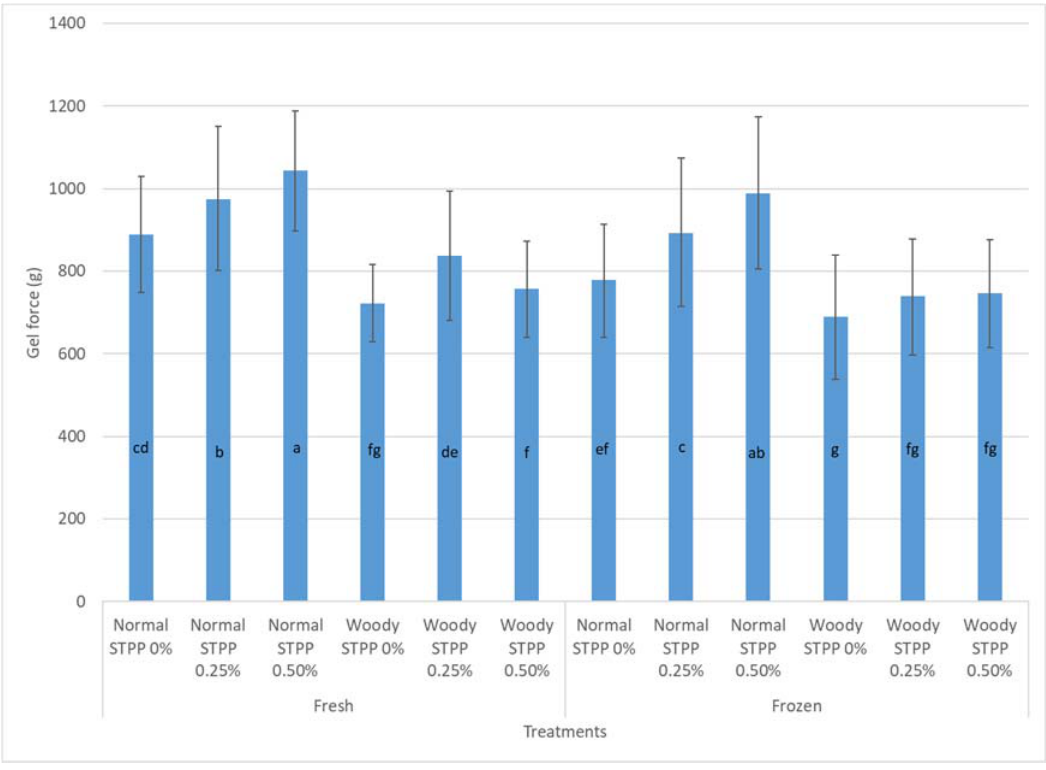
Figure 1. Gel strength (g) of fresh vs. frozen ground chicken breast meat prepared with woody and normal breast fillets with sodium tripolyphosphate (STPP; 0, 0.25, 0.5%) incorporated into the ground chicken meat ( n = 20; Standard Error of Mean = 37.81). The dispersion bars represent standard deviation for each treatment. a–g Bars with common letters are not different ( p > 0.05).